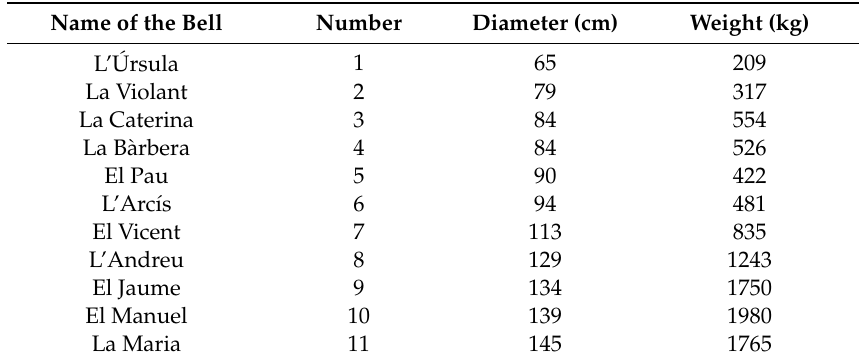
Table 1. Description of the